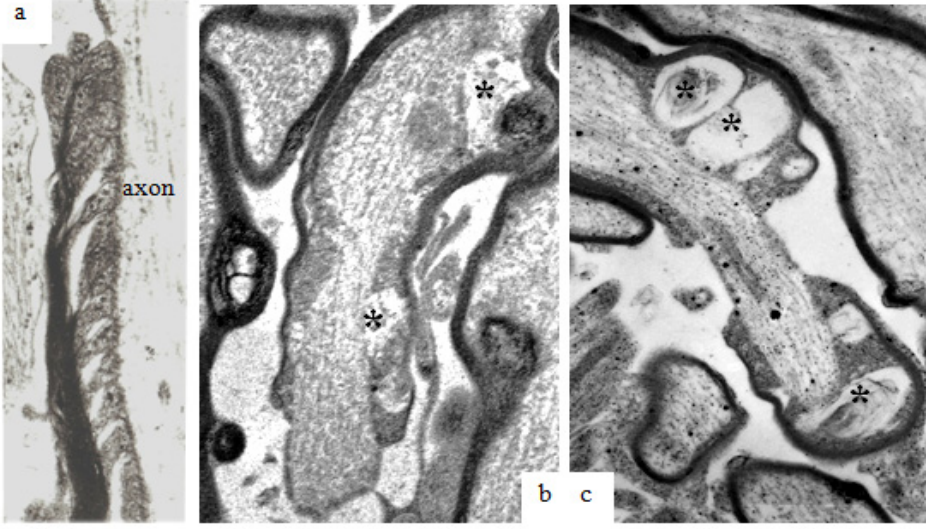
Figure 7. Longitudinal sections through paranodes of injured nerve fibers at 1 h, 4 h and 24 h after stretch-injury to the right optic nerve of adult guinea-pigs. In ( a ) at 1 h, ellipsoid lucent spaces of “paranodal spiral clefts” occur between neighboring oligodendrocyte paranodal glial loops. At 4 h ( b ) and 24 h ( c ) after injury “paranodal spiral clefts” appear to have increased in volume and contain small aggregates of pyroantimonate crystals ( * ). In these fibers, paranodal glial loops are rather more electron dense and contain cytoplasmic organelles but have become etiolated due to the increased volume of fluid within the spiral clefts because the adaxolemma tips are still adherent to the external aspect of